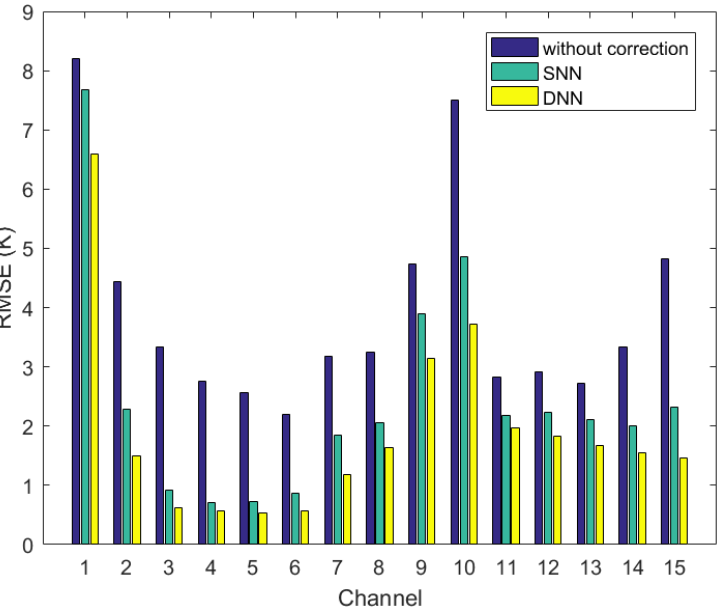
Figure 8. RMSEs between the observed brightness temperatures and the simulated brightness tem- peratures before and after bias correction. temperatures before and after bias